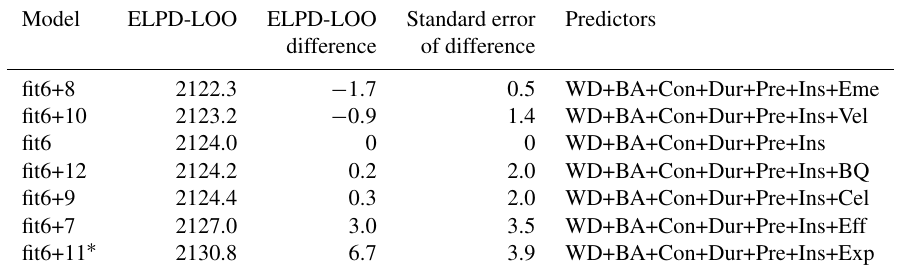
Table 4. Comparison of the flood-type model candidates by their difference in ELPD-LOO using the first six predictors plus one predictor at a time, ranked by increasing predictive accuracy, along with their differences and the standard error of the differences with reference to the model “fit6” (see Table S2 for all model